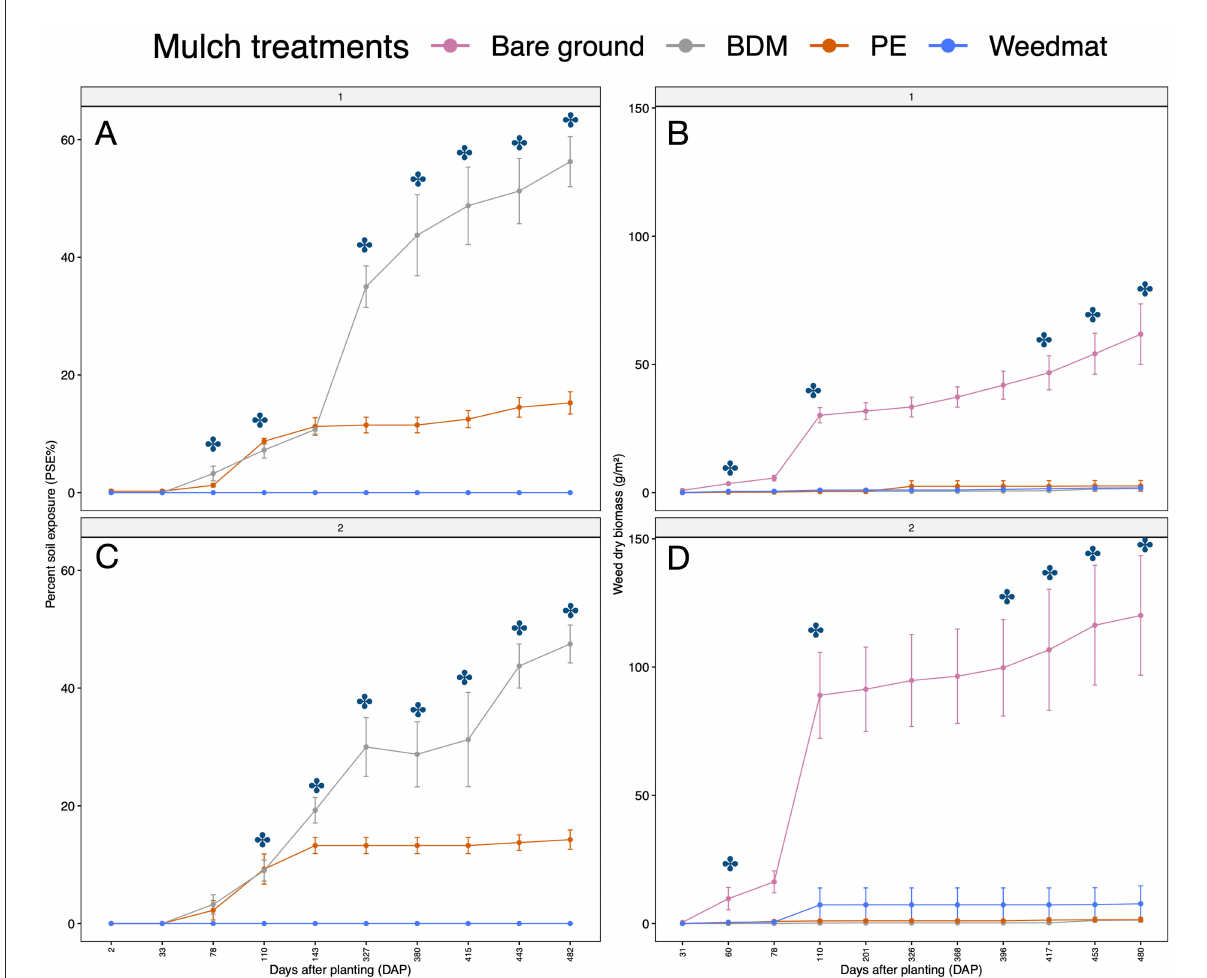
FIGURE1 Cumulative weed dry biomass (g · m − 2 ) per m 2 and percent soil exposure (PSE, %) in plots with polyethylene (PE), soil-biodegradable mulch (BDM), weedmat, or bare ground treatments in a Mediterranean climate between May 2020 and Sept. 2021. means weed dry biomass or PSE differed due to mulch treatment ( P < 0.05). (A,B) represent rotation 1 data, (C,D) rotation 2 data. PSE was not recorded in bare ground